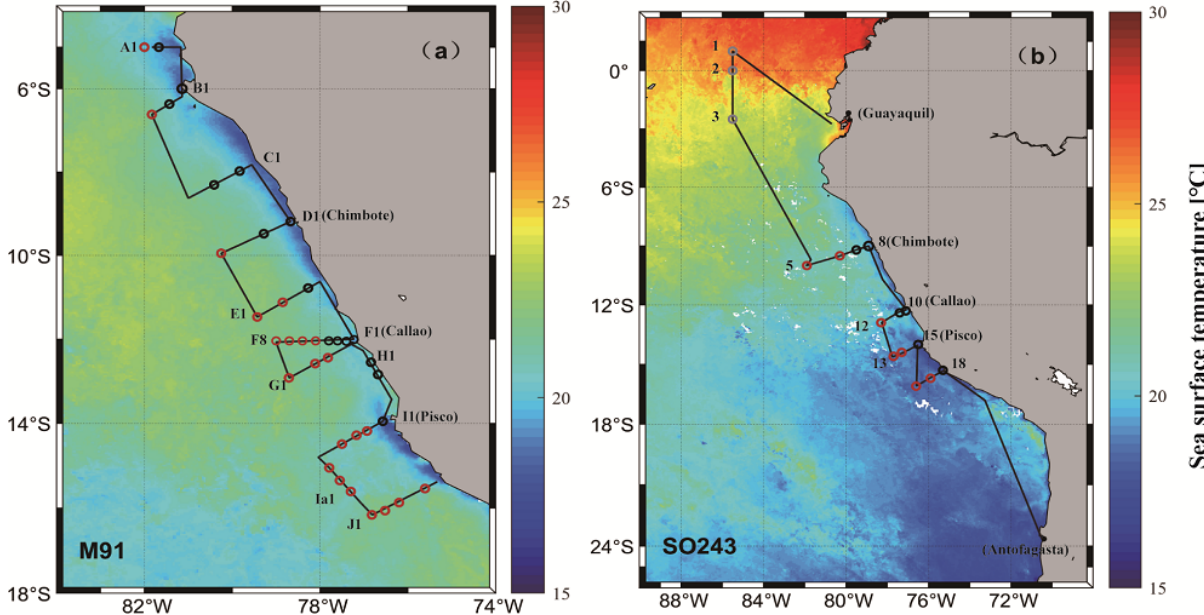
Figure 1. Cruise tracks of M91 (a) and SO243 (b) plotted on top of monthly mean SST detected by the Moderate Resolution Imaging Spectroradiometer (MODIS) instrument on board the Aqua satellite. Red circles indicate offshore stations, and black circles indicate coastal stations in both panels. Grey circles in panel (b) indicate equatorial stations. Note that no CTD cast was performed at stations 4 and 9 during cruise